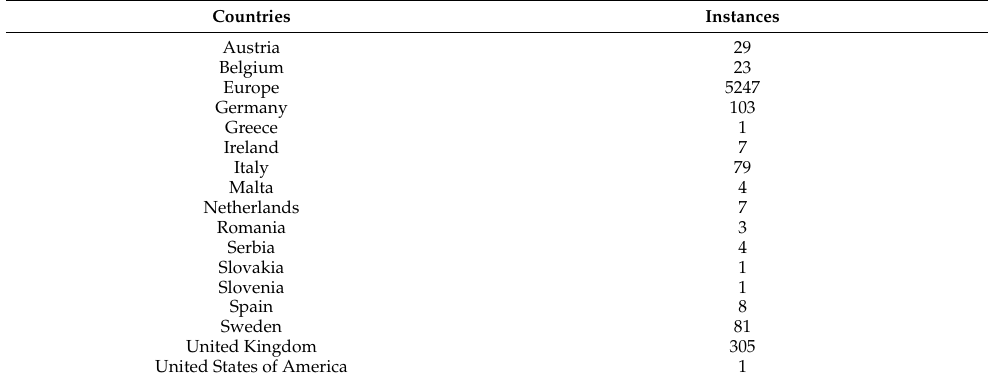
Table 2. Countries of origin of the various data instances.